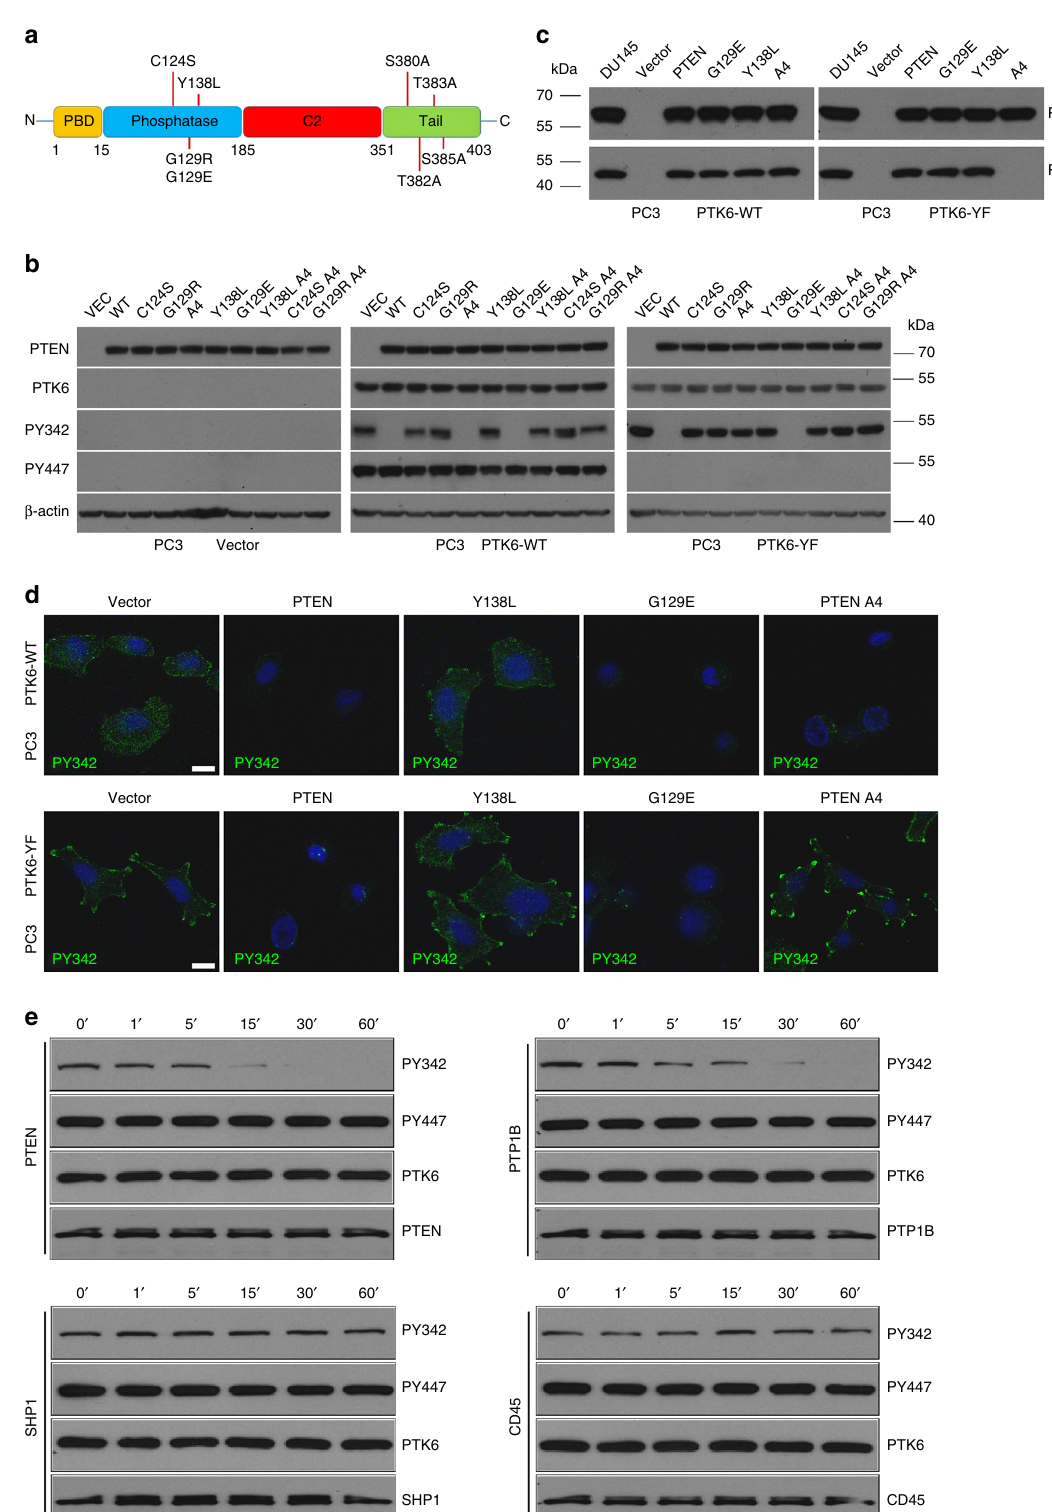
NATURE COMMUNICATIONS | 8: